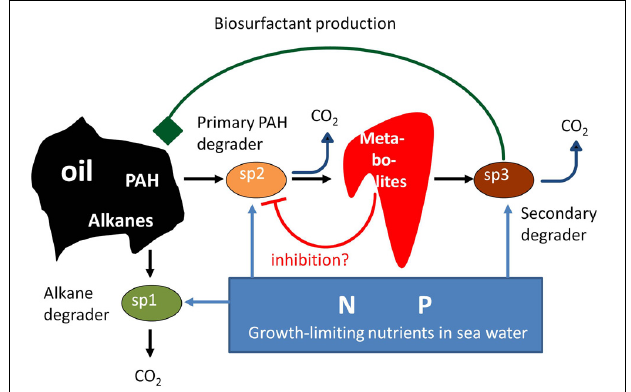
FIGURE 1 | Several potential interactions during oil-mineralization that may affect the rate and extent of biodegradation of marine oil spills. Alkane- and PAH-degrading specialists compete for limiting nutrients in seawater. We extrapolate findings on a benzo[a]pyrene degrading, soil-derived consortium (Kanaly et al., 2002) to marine oil spills (Head et al., 2006) to indicate potential positive mutualistic interactions. The consortium was found to contain a key member (indicated by Sp3) that was unable to degrade the PAH benzo[a]pyrene but excreted factors that aided its degradation and presumably grew on metabolites excreted by other, benzo[a]pyrene-degrading community members (indicated by Sp2).